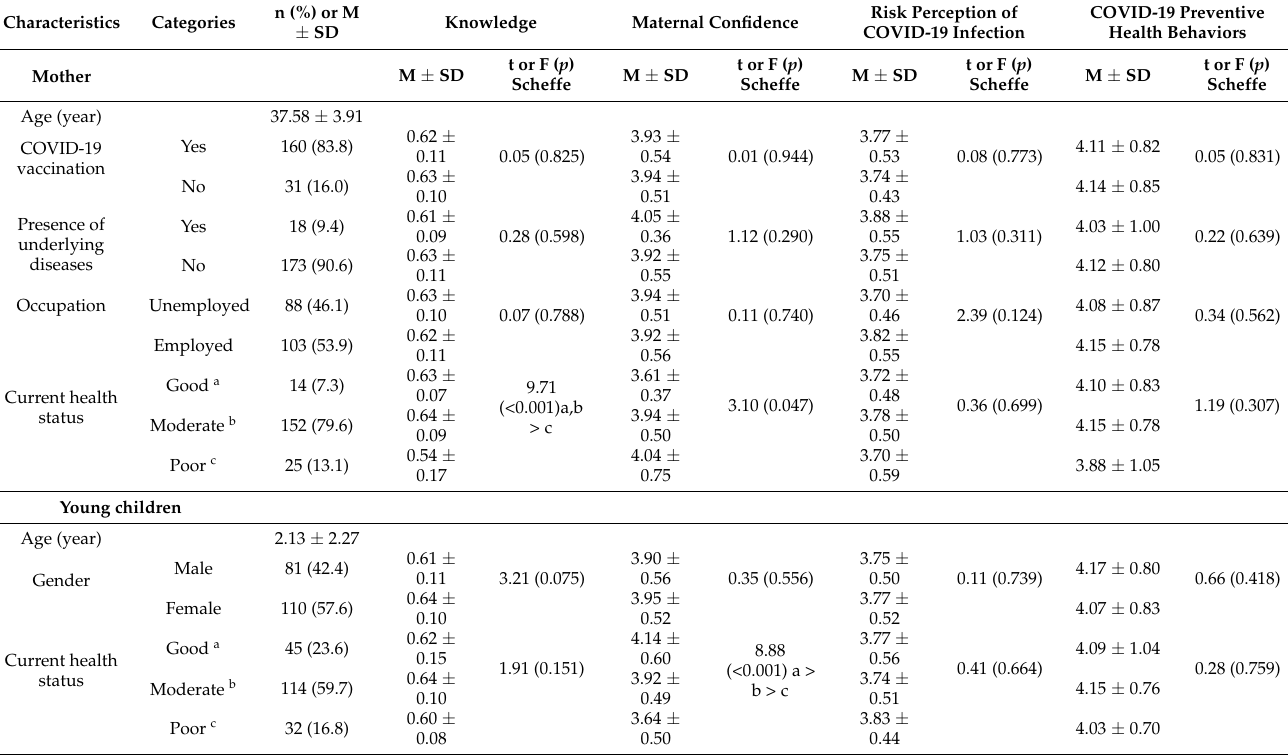
Table 1. General characteristics and research variables of participants ( N =